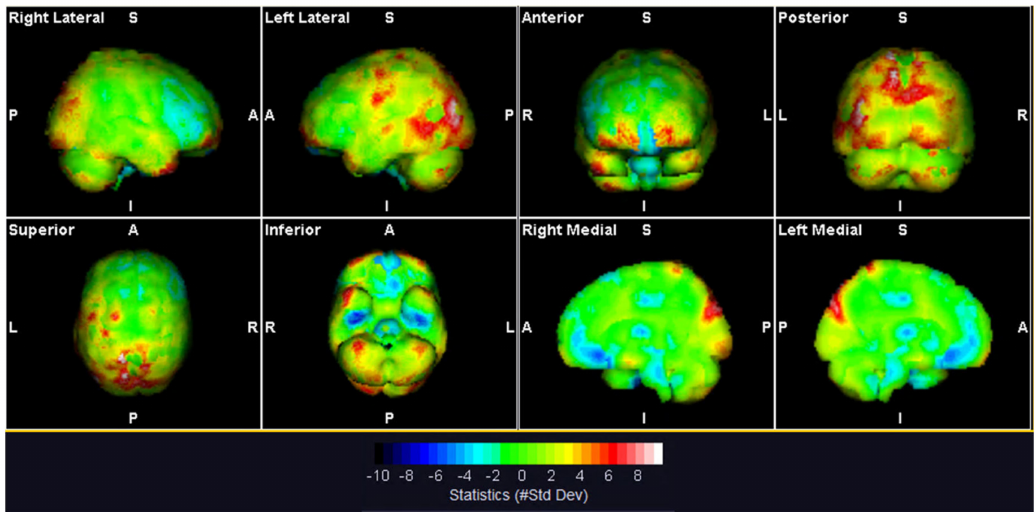
Figure 1. 3D visualization of patient positron emission tomography (PET) in comparison with normal